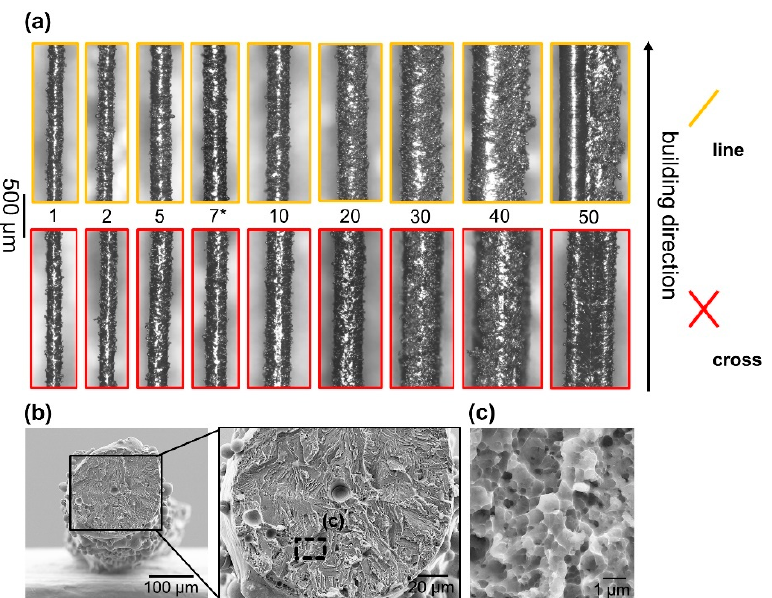
Figure 3. Overview of single struts fabricated with different scan vector lengths ( a ). The color-code corresponds to the highlighted specimens in Figure 1b, viz. line and cross quasi-P scanning. Please note that the indicated exposures are only shown schematically perpendicular to the building direction. As marked (*), a selected specimen from previous tests [20] was used for a detailed analysis of the fracture surface after tensile loading ( b ). A magnified image of the fracture surface is shown in ( c ). For tensile testing, specimens produced with vector length factors from 1 (“short” scanning vectors) to 10 (“long” scanning vectors) were chosen.